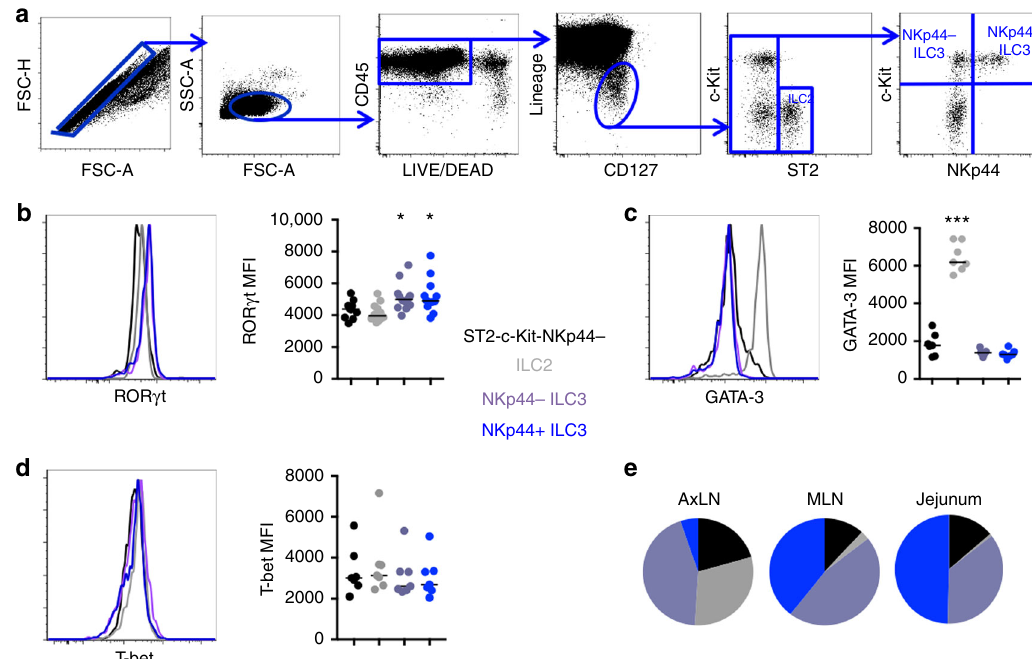
Fig. 1 De fi ning ILCs in nonhuman primates. a Representative gating strategy for ILCs in the MLN of a healthy animal. b ROR γ T expression in MLN ILC subpopulations ( N = 9). c GATA-3 expression in MLN ILC subpopulations ( N = 7). d T-bet expression in MLN ILC subpopulations ( N = 7). e Relative distribution of ILC subtype frequencies as a proportion of total lineage CD127 + cells in axillary, mesenteric lymphoid tissues, and jejunum ( N = 7). Statistical signi fi cance was calculated using the Mann – Whitney test. ns = P > 0.05, * = P ≤ 0.05, ** = P ≤ 0.01, *** = P ≤ 0.001, and **** = P ≤